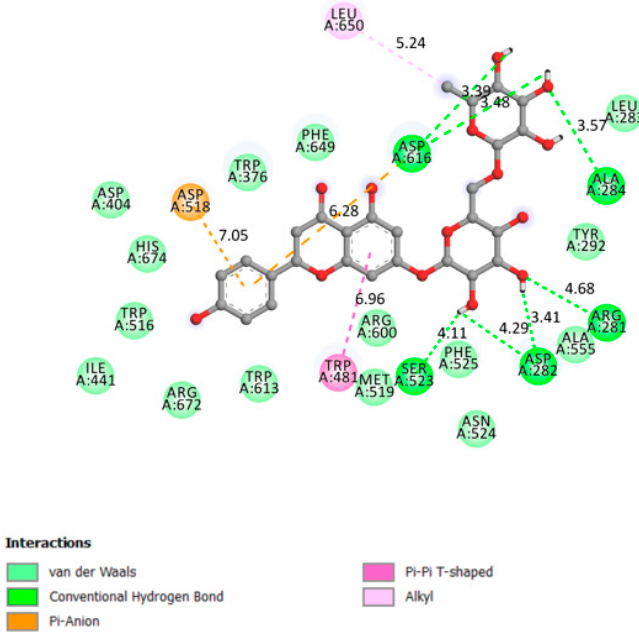
Figure 6. Two-dimensional scheme of the narirutin interactions with AGL.